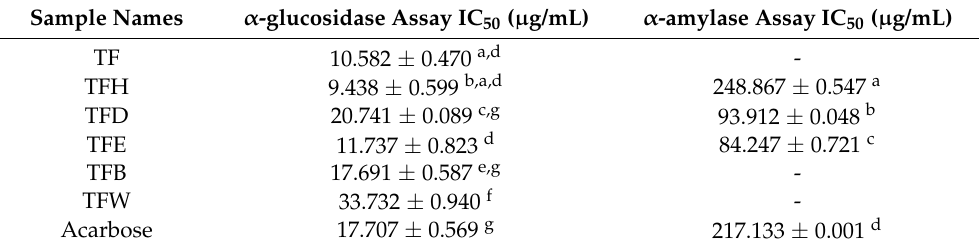
Table 1. α -Glucosidase and α -amylase IC 50 values of the R. iconiensis flower extracts/sub-extracts.